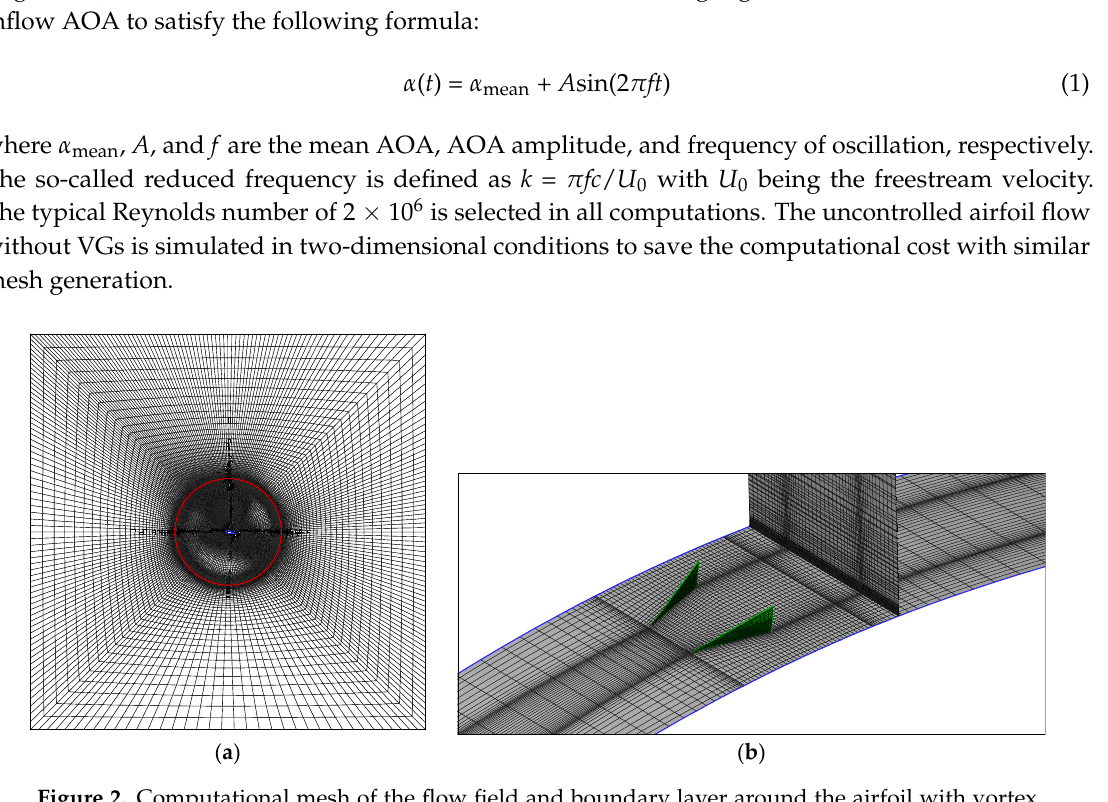
Figure 2. Computational mesh of the flow field and boundary layer around the airfoil with vortex generators. The red circle denotes the sliding interface: ( a ) flow field mesh; ( b ) wall surface and boundary layer mesh.